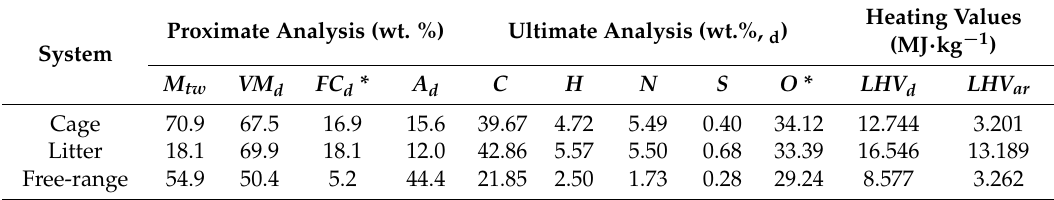
Heating Values (MJ · kg − 1